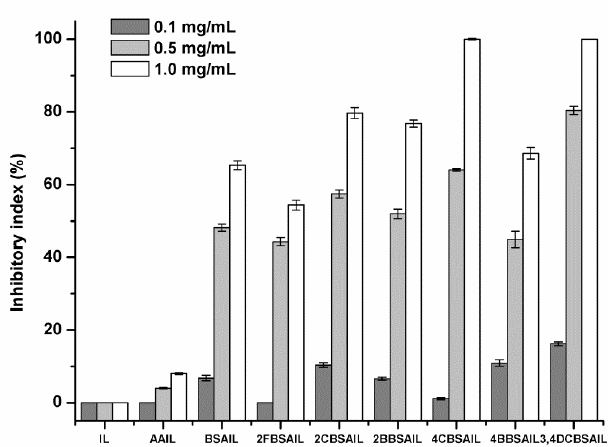
Figure 6. The antifungal activity of inulin, AAIL, and inulin derivatives against Botrytis cinerea .